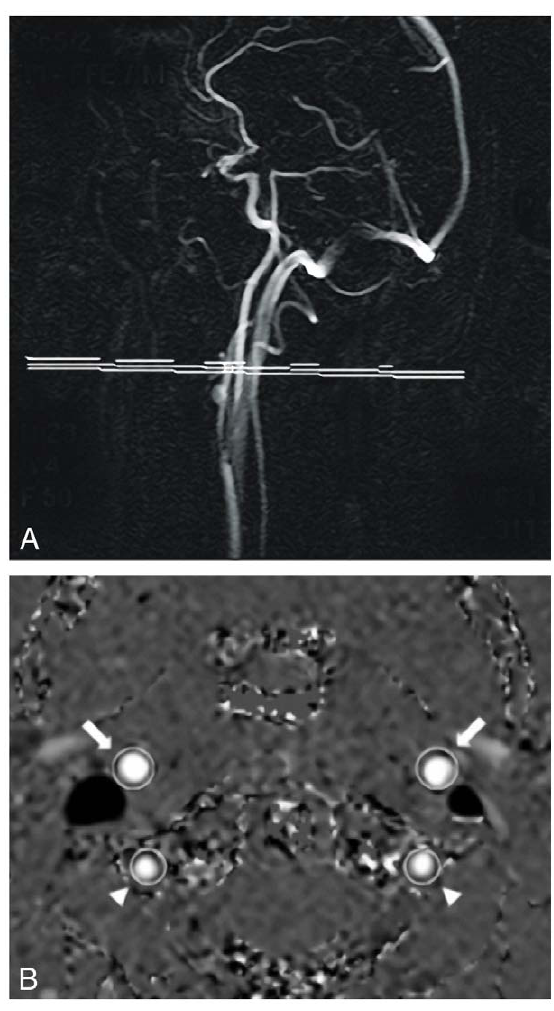
Figure 1. Single slice phase contrast MR angiography. Saggital MRA scout image of the main brain feeding arteries ( a ). The white slab represents the position of the transverse angiographic phase image. This image shows the carotid arteries (arrows) and vertebral arteries (arrowheads) over which flow was measured ( b ).